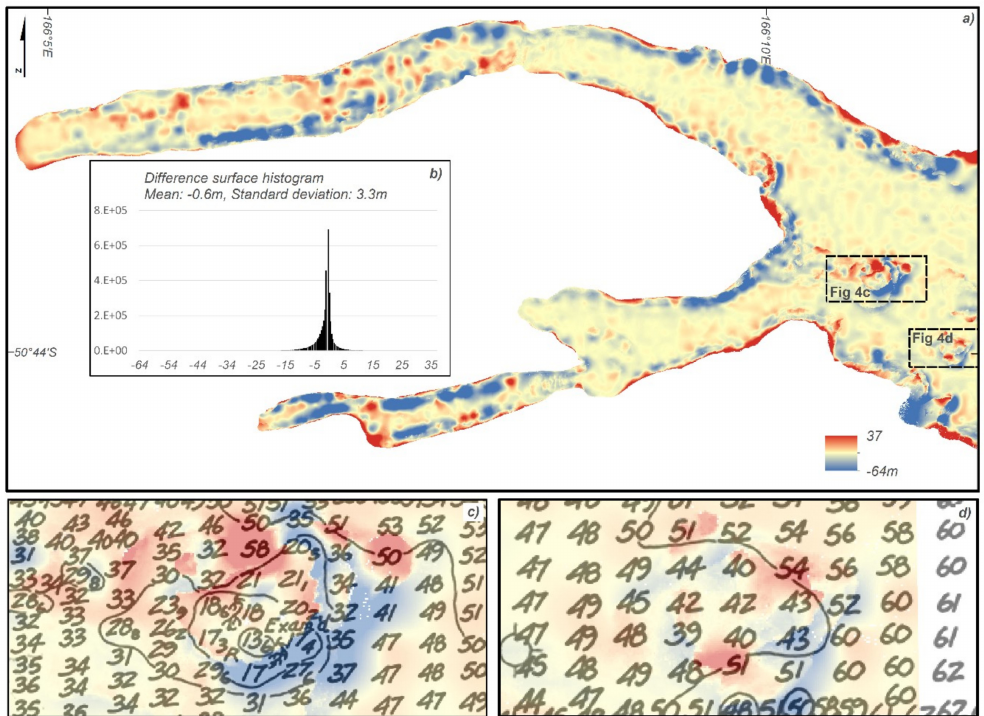
Figure 4. Norman and Hanfield Inlet differencing: ( a ) Difference between post-2015 multibeam surface and pre-2015 fairsheet surface, note buff color is − 0.7 m; ( b ) histogram of differences with 1 m bins; ( c & d ) areas of rock outcrops used for shoal analysis with pre-2015 fairsheet